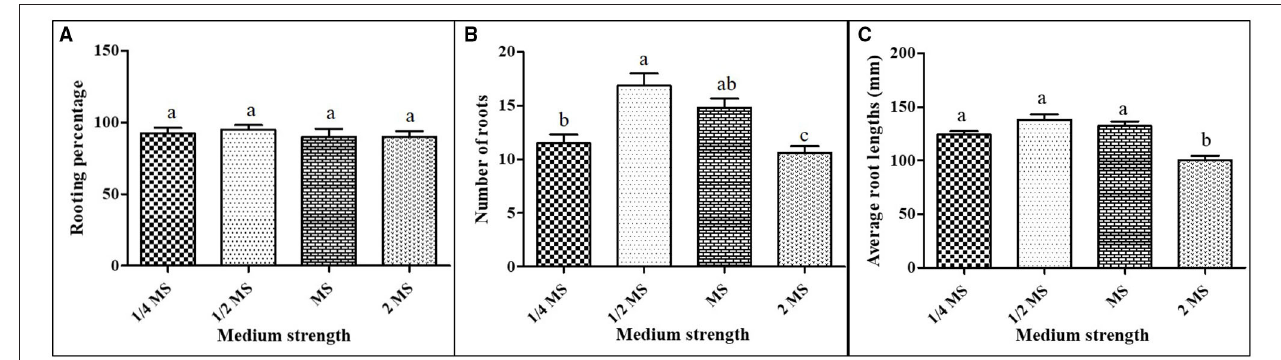
FIGURE 4 | Rooting of A. africana regenerated shoots in MS media of different strengths supplemented with 0.1 mg/L NAA: (A) the number of roots, (B) root lengths, and (C) rooting percentage. Values are presented as means ± SE. The same letters are not significantly different by Tukey’s multiple comparison test and p =